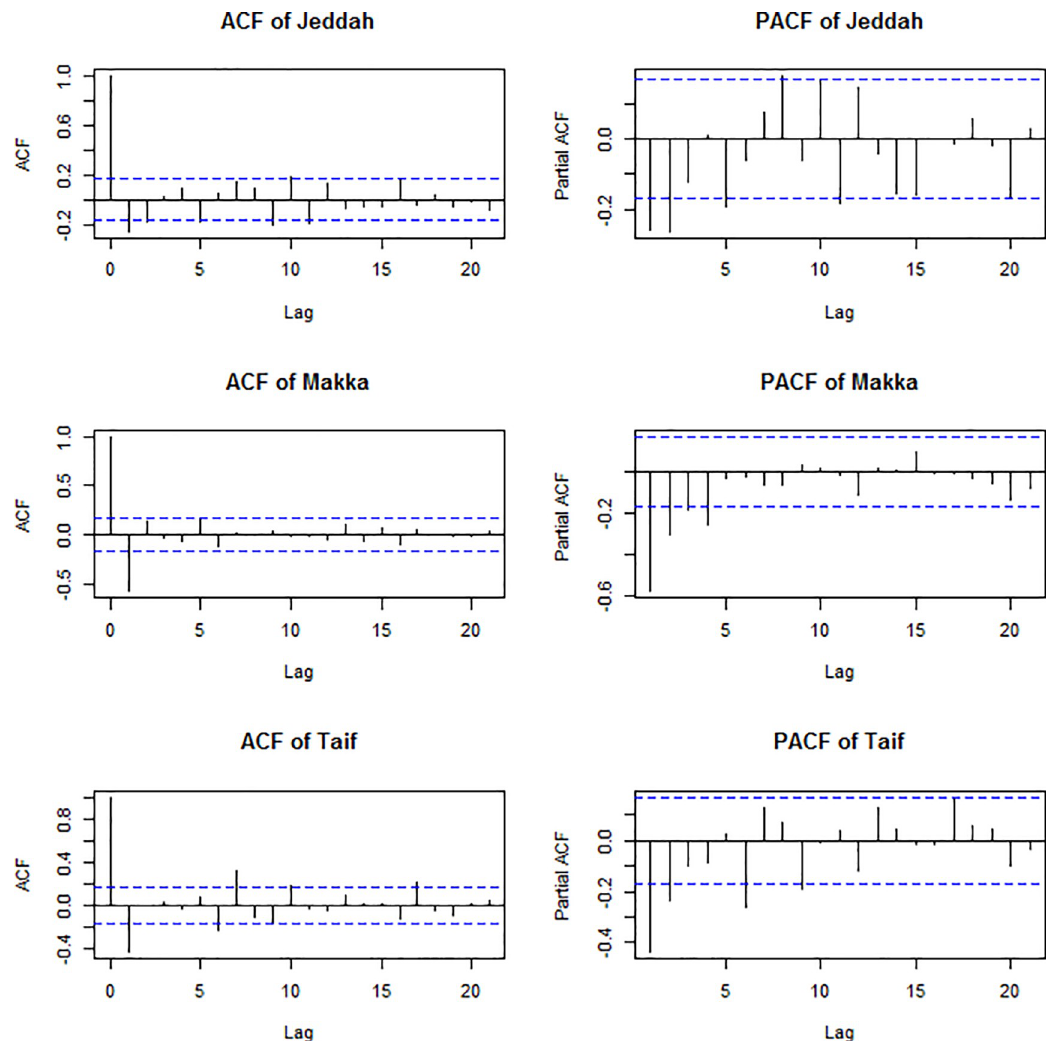
Fig 4. ACF and PACF of the differenced